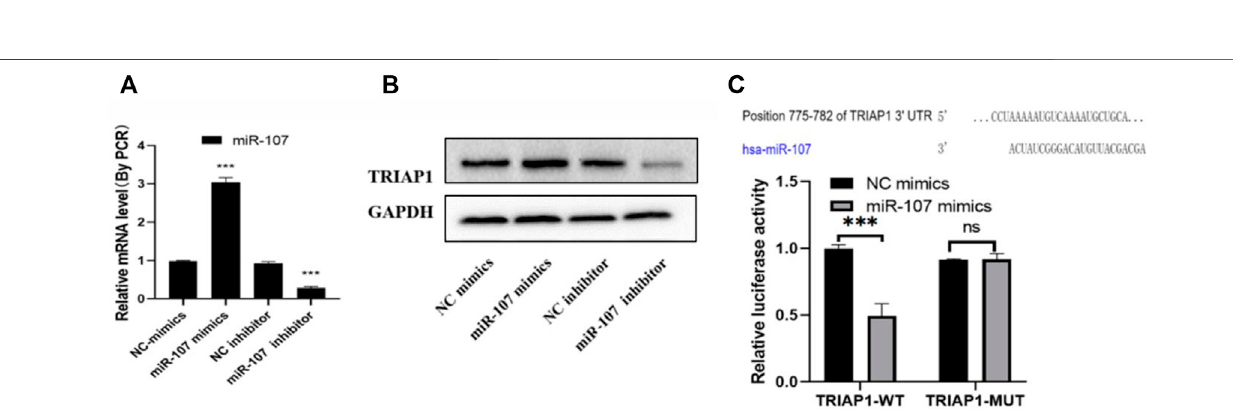
Frontiers in Genetics |